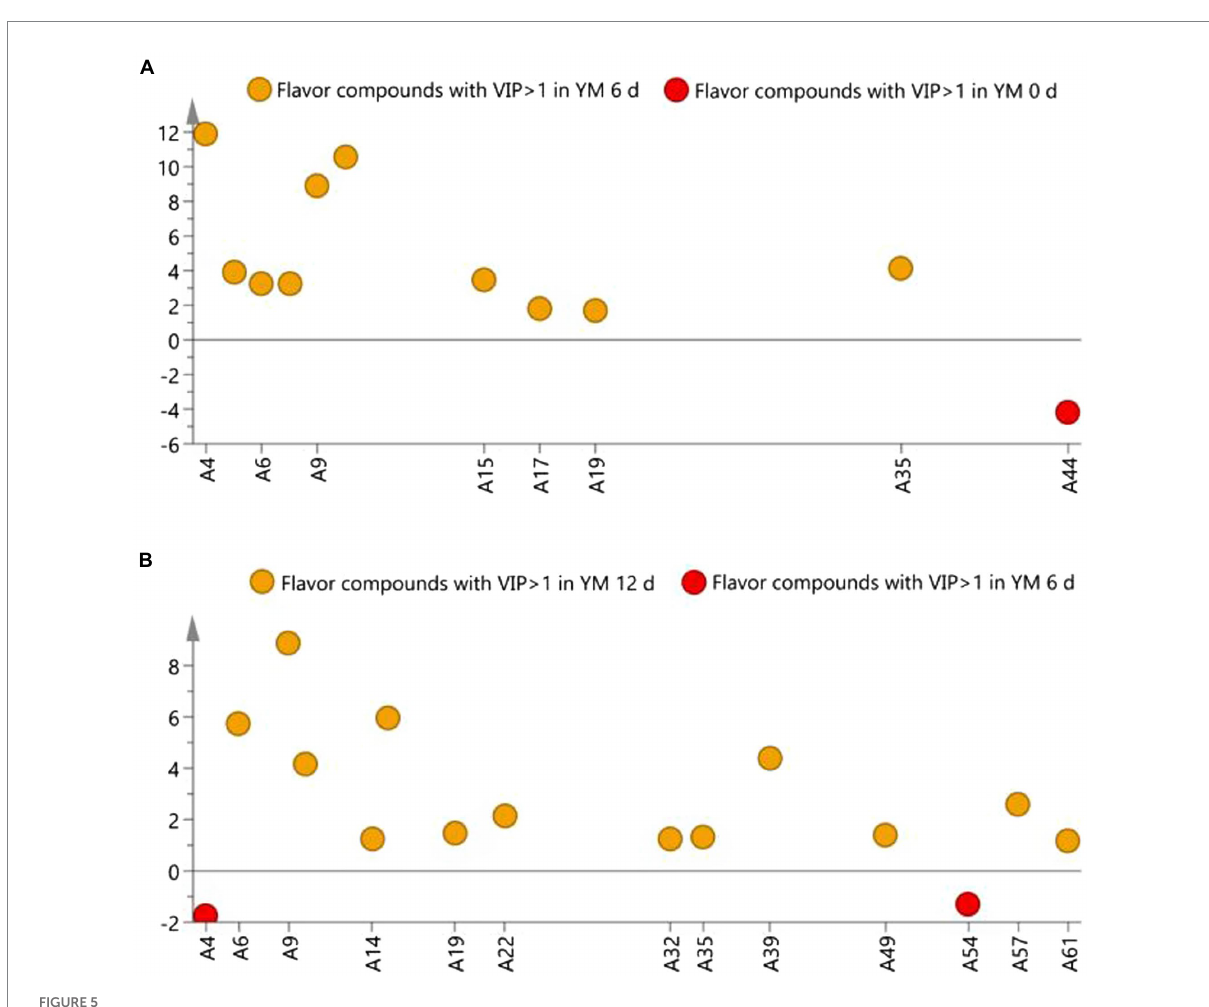
FIGURE 5 S-line scatter plot based on OPLS-DA model